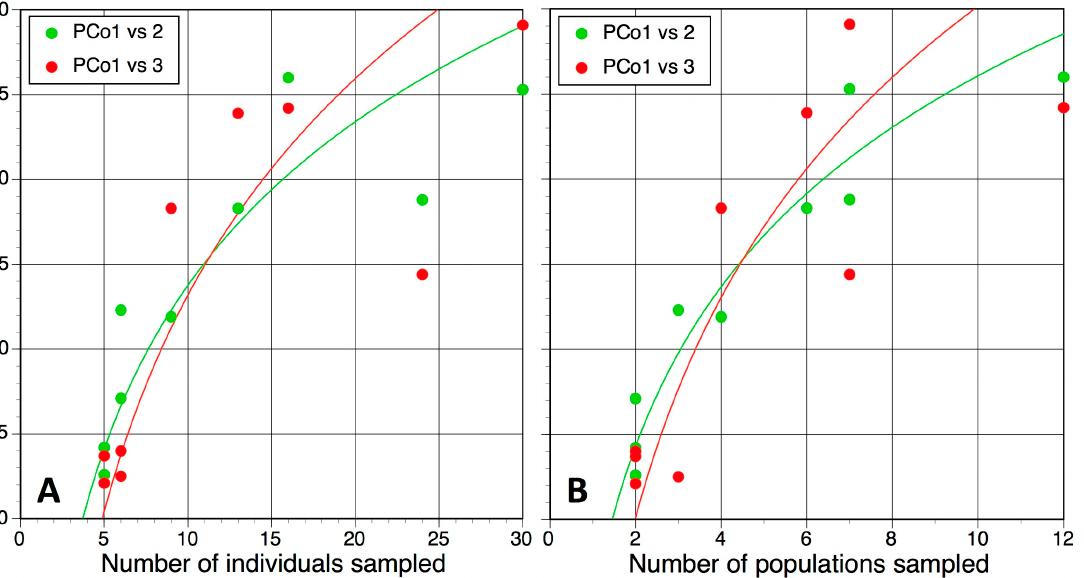
Figure 17. Relationship between the morphospace occupied by the nine best-sampled microspecies of macrospecies Fuciflora versus sampling effort, as measured in numbers of individual plants ( A ) and source populations ( B ) and compared for two morphometric planes (PCo1 vs. 2 and 1 vs. 3: see also Table 2).